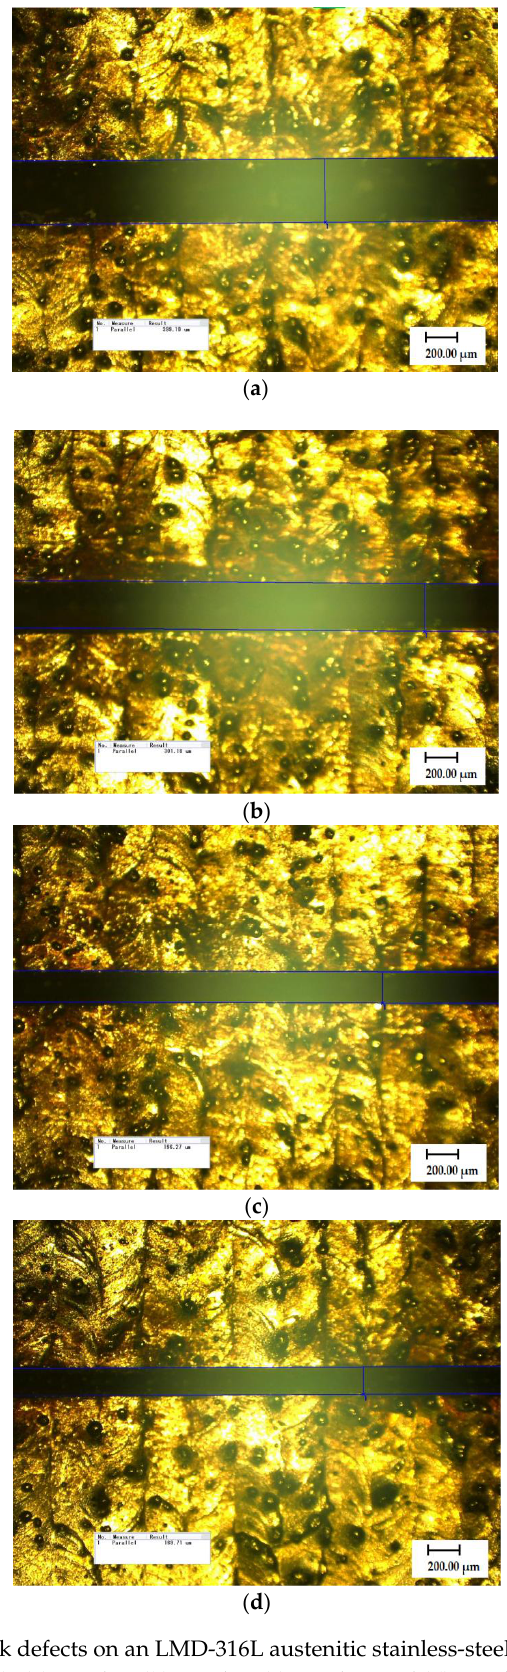
optical microscopy (×100): ( a ) Crack 1; ( b ) Crack 2; ( c ) Crack 3; and ( d ) Crack 4.